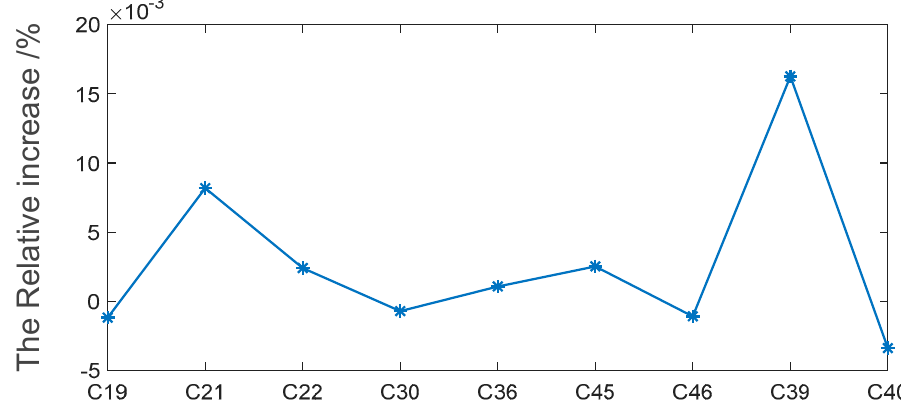
Figure 21. Relative increase in PLL discriminator output accuracy for B2a signal.